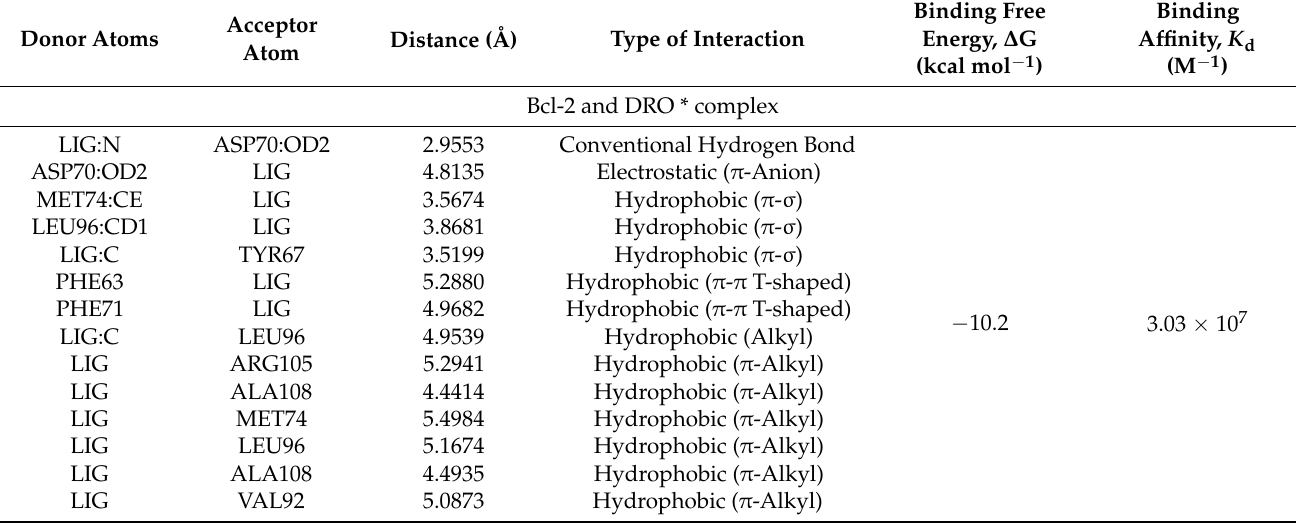
Table 2. Molecular docking of chlorojanerin and DRO (control ligand) with